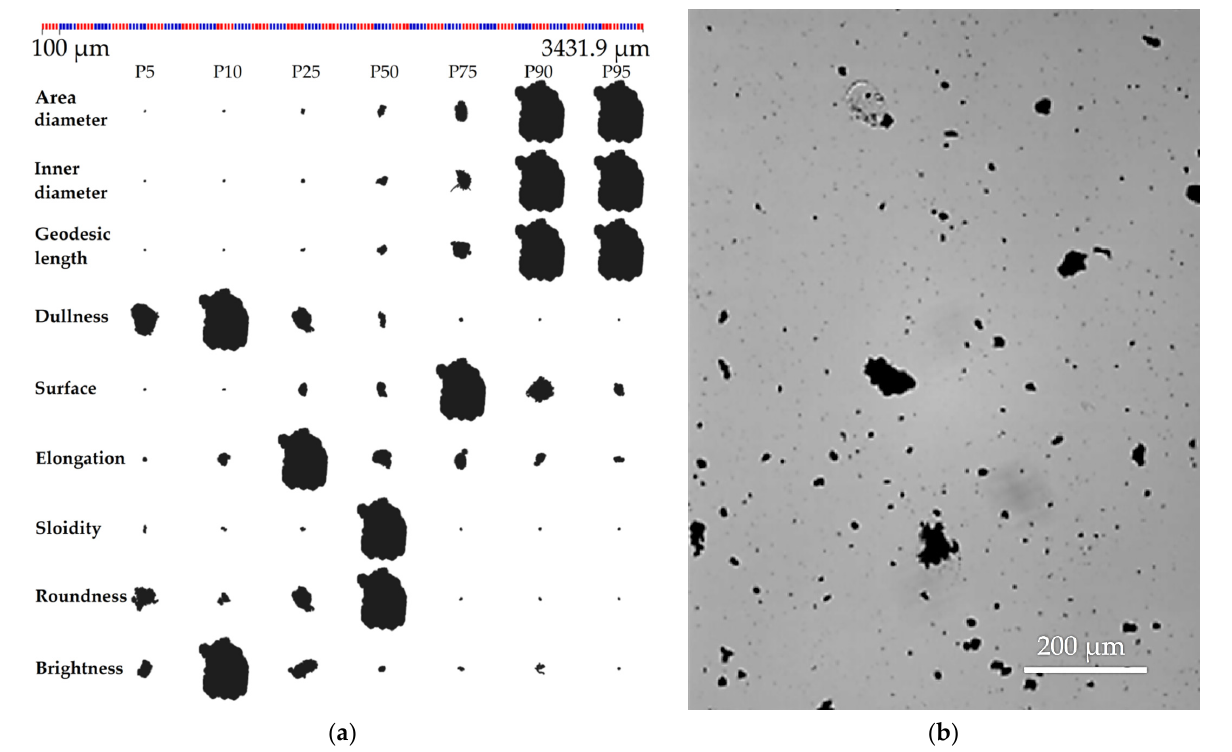
Figure 3. Granulomorphometric analysis of the composition of ZnO powder ( a ) and morphology ( b ).